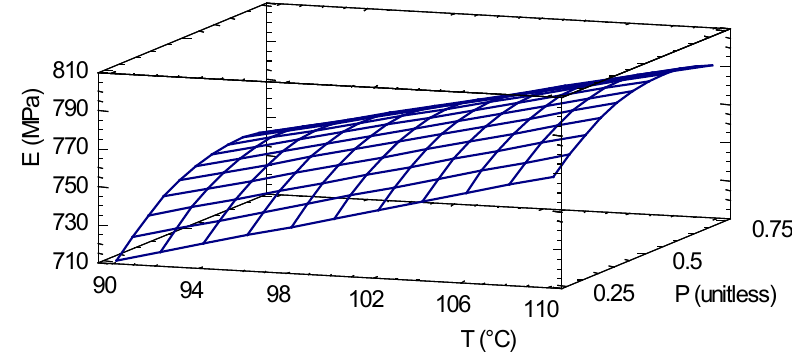
Figure 10. Estimated response surface for the modulus of elasticity considering the process temperature and the proportion of rice husk for a compaction time of 40 s.